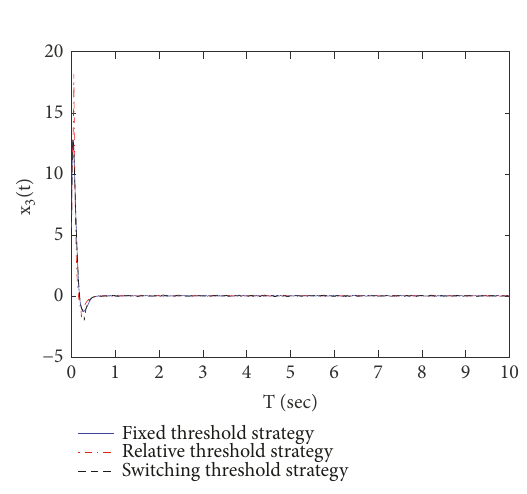
Figure 8: State signal 𝑥 3 (𝑡) .